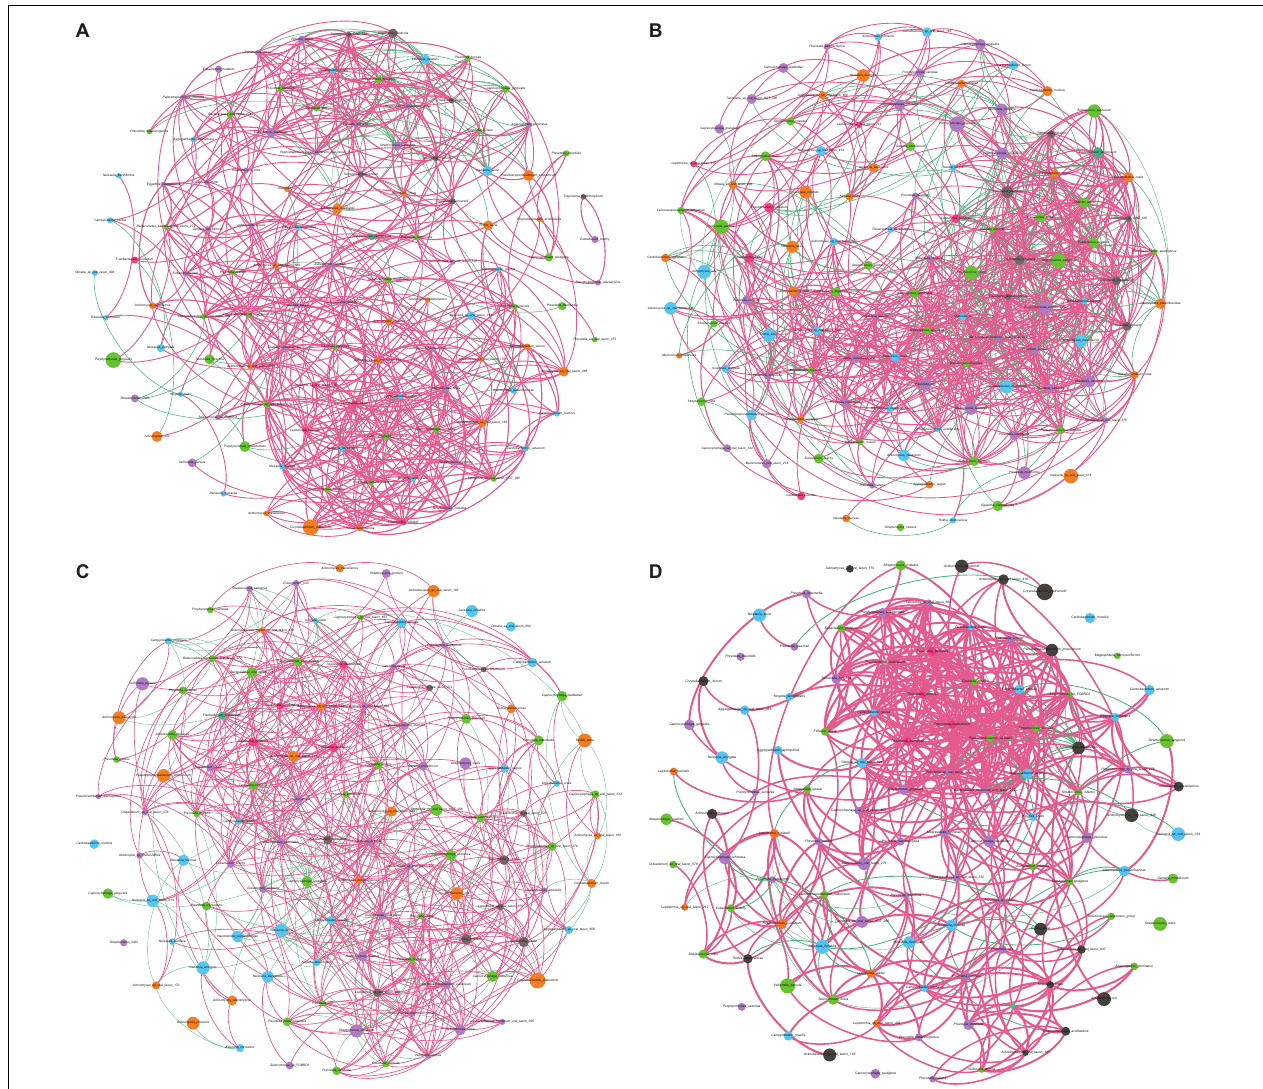
FIGURE 2 | Bacterial co-occurrence networks. (A) Network of diseased subgingival microbiome. (B) Network of healthy subgingival microbiome. (C) Network of diseased supragingival microbiome. (D) Network of healthy supragingival microbiome. Species from different phyla were marked in different colors. The larger nodes represented the higher mean relative abundance of the species. We selected those interactions with Spearman correlation coefficient < -0.6 or > 0.6 (adjusted p < 0.05). Positive and negative correlations are shown in red and green lines, respectively. Thicker lines meant higher absolute values in Spearman coefficient. Generally, the healthy subgingival network was more complex than the diseased subgingival network, while the healthy supragingival network was less complex than the diseased supragingival network.